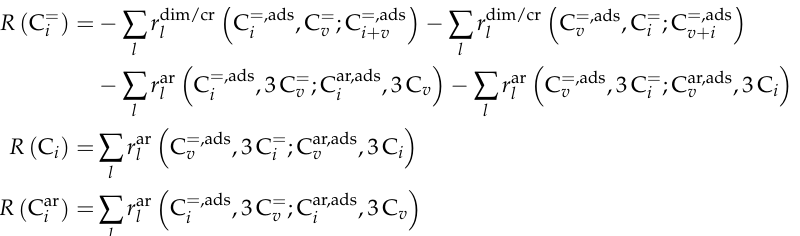
, from 6 to 8 for R and from 2 to 8 for R ( C i ) , respectively; the same C = C ar i i (cid:0) (cid:1) (cid:0) (cid:1)